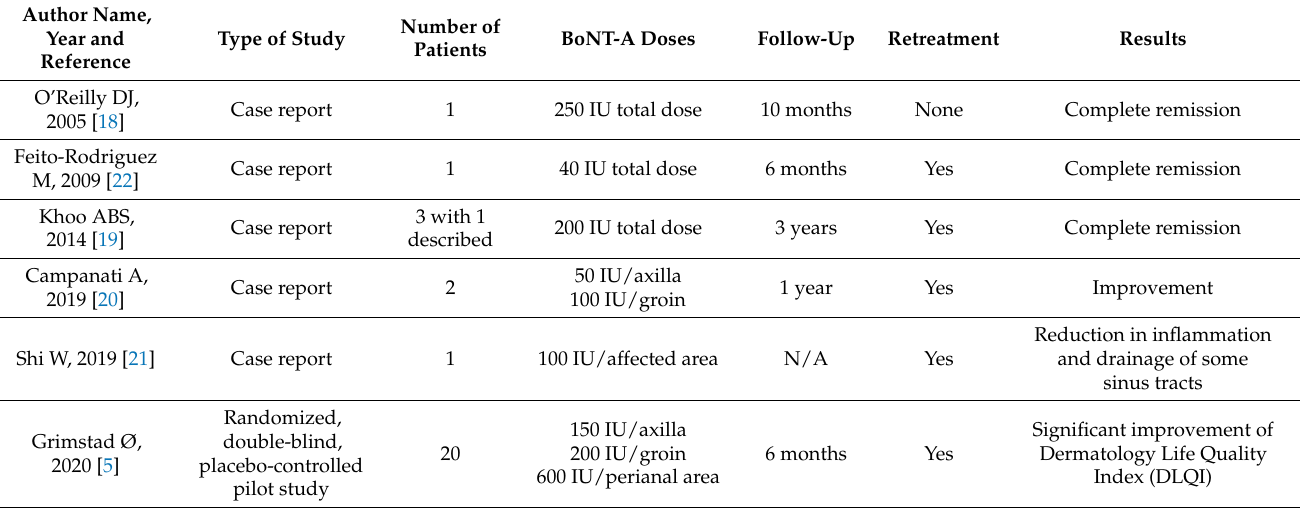
Table 1. BoNT-A in hidradenitis